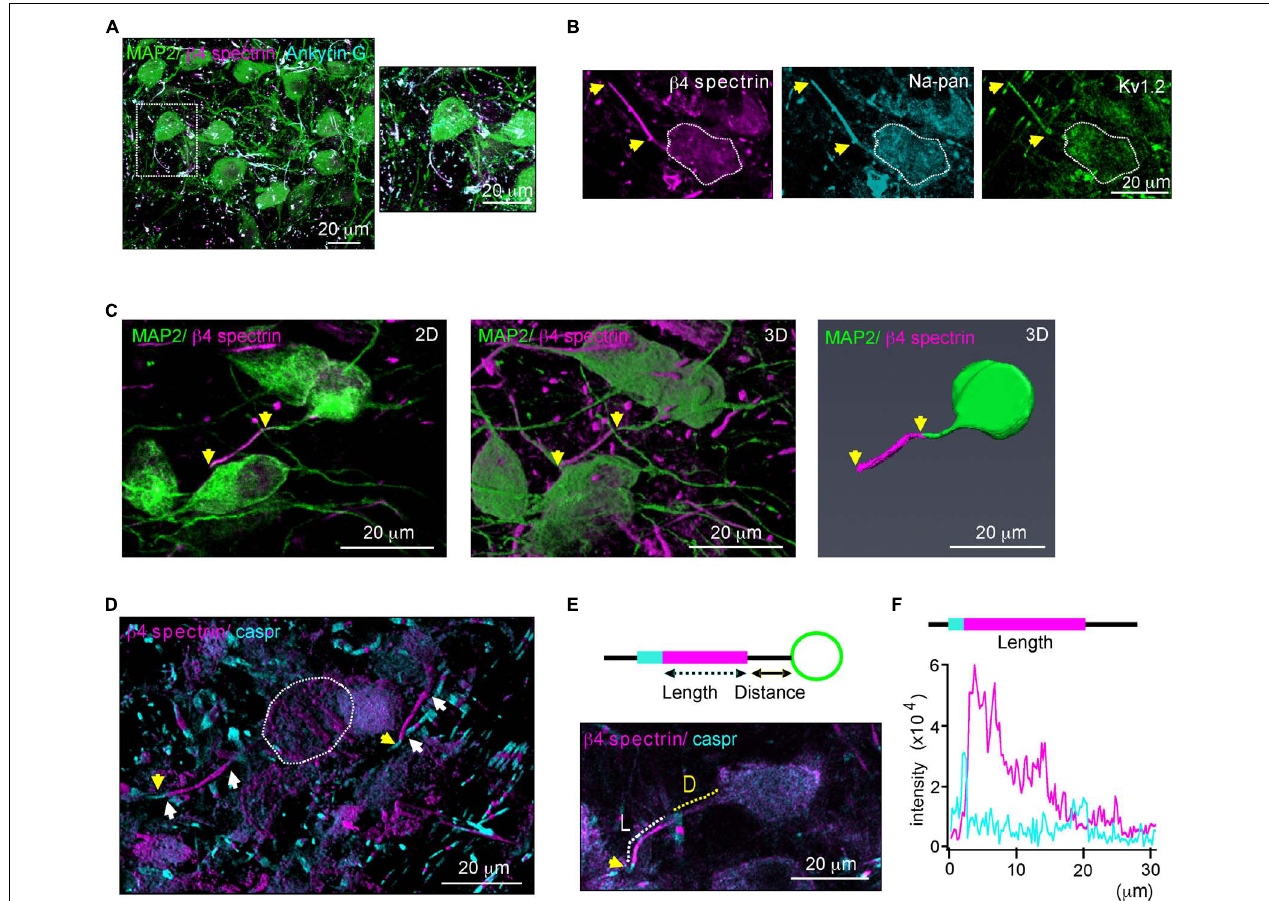
FIGURE 1 | β 4 spectrin is co-localized with ankyrinG and Na + and K + channels. (A) Immunostaining of MNTB neurons with MAP2 (blue), β 4 spectrin (green) with ankyrinG (magenta) of P20 normal hearing mice. Dotted line indicates the soma of MNTB neuron. (B) MNTB neurons immunostained with β 4 spectrin (cyan), voltage-activated Na + channel (Na-pan, green) and K + channel (K V 1.2, magenta). Dotted line indicates the soma of MNTB neuron. (C) 2D compressed Z-stack images (left) and 3D reconstructed Z-stack images using Zen (middle) and Amir (right) of the same MNTB neuron immunostained with MAP2, β 4 spectrin. Yellow arrows indicate AIS length. (D) Immunostaining of the MNTB with β 4 spectrin and caspr. White arrows indicate the AIS proximal and distal ends. Capsr (magenta, yellow arrows) was located at the next of the AIS distal end. (E) (Top) Diagram of the MNTB neuron with soma (green), AIS (cyan), and paranode (magenta) shows the AIS length and distance from the soma. (Bottom) MNTB neurons immunotained with MAP2 (green), β 4 spectrin (magenta) and caspr (cyan). A dotted line indicates the length (L, white) and distance (D, yellow) of AIS structure. (F) The intensity profiles of β 4 spectrin (magenta) and caspr (cyan) immunostaining along the AIS of MNTB neuron indicated by length and distance in E .